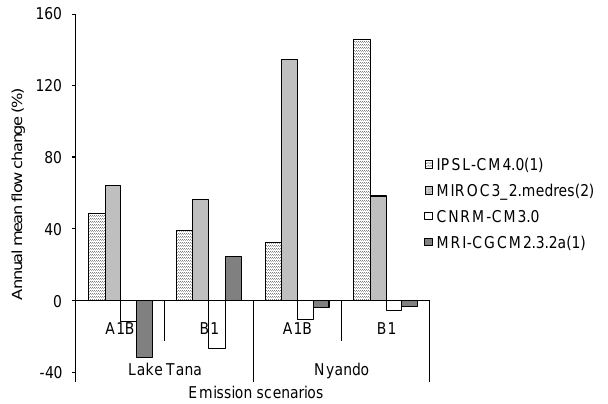
Figure 11: Regional projected change comparison of mean annual flow volumes between Nyando and Lake Tana catchments for eight GCM runs (VHM results)